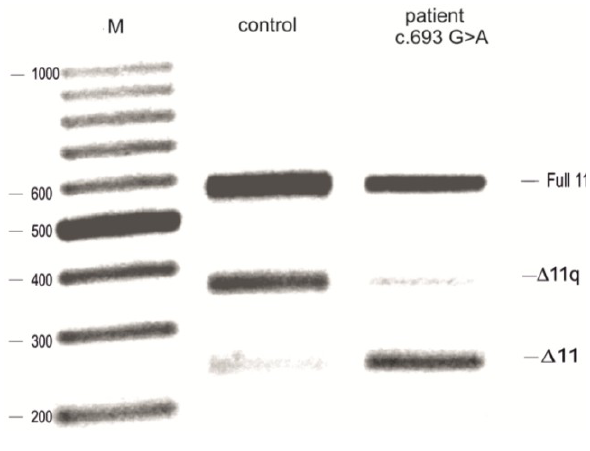
Figure 1. Analysis of BRCA1 cDNA from blood of a patient carrying the